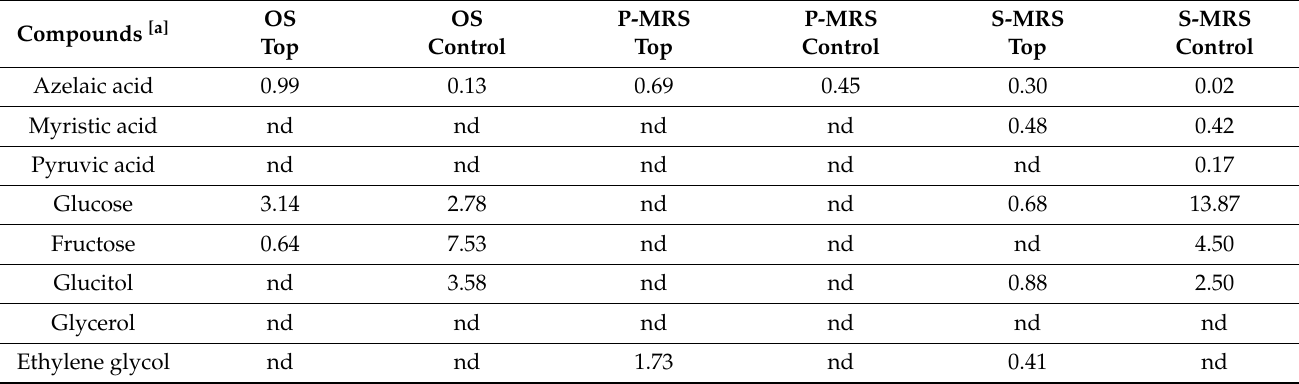
Table 2. Abundance of main compounds detected with Gas Chromatography–Mass Spectrometry analysis after ground- based simulation.